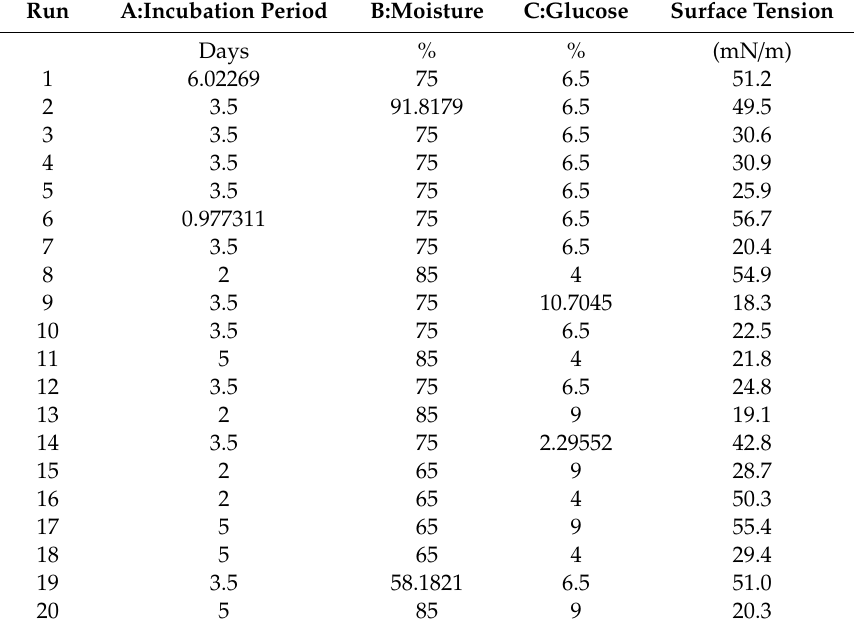
Table 3. Central composite design for the selected three variables for the production of biosurfactants in solid-state fermentation.